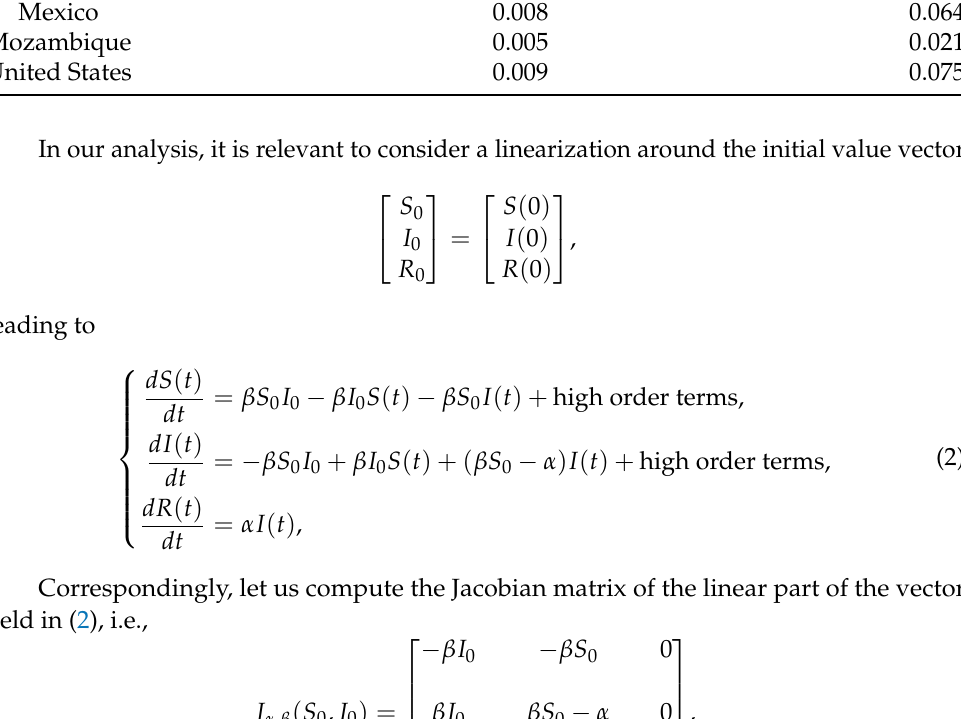
Table 1. Values of the constants α , β , for France, India, Italy, Mexico and the United States, referring to 2019. α β Australia 0.009 0.087 0.008 0.072 0.009